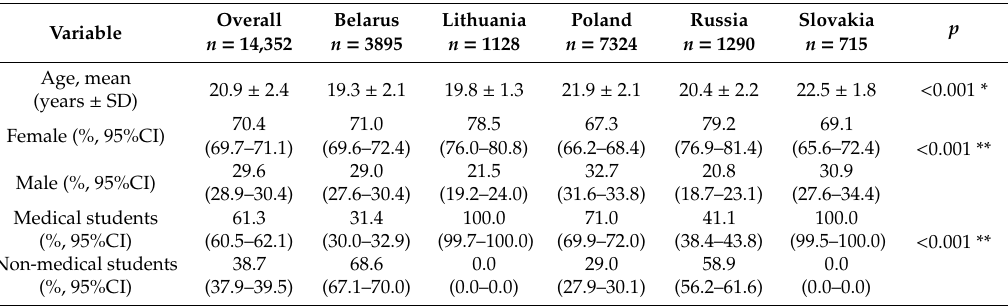
Table 1. Description of the participants by